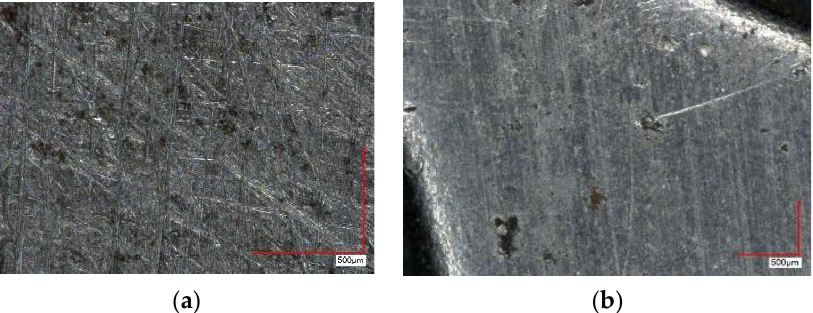
Figure 13. PMM microstructure with traces of corrosion: they can be superficial ( a ) and deeper ( b ). The growth of emerging markets increases the importance of a local presence [47].